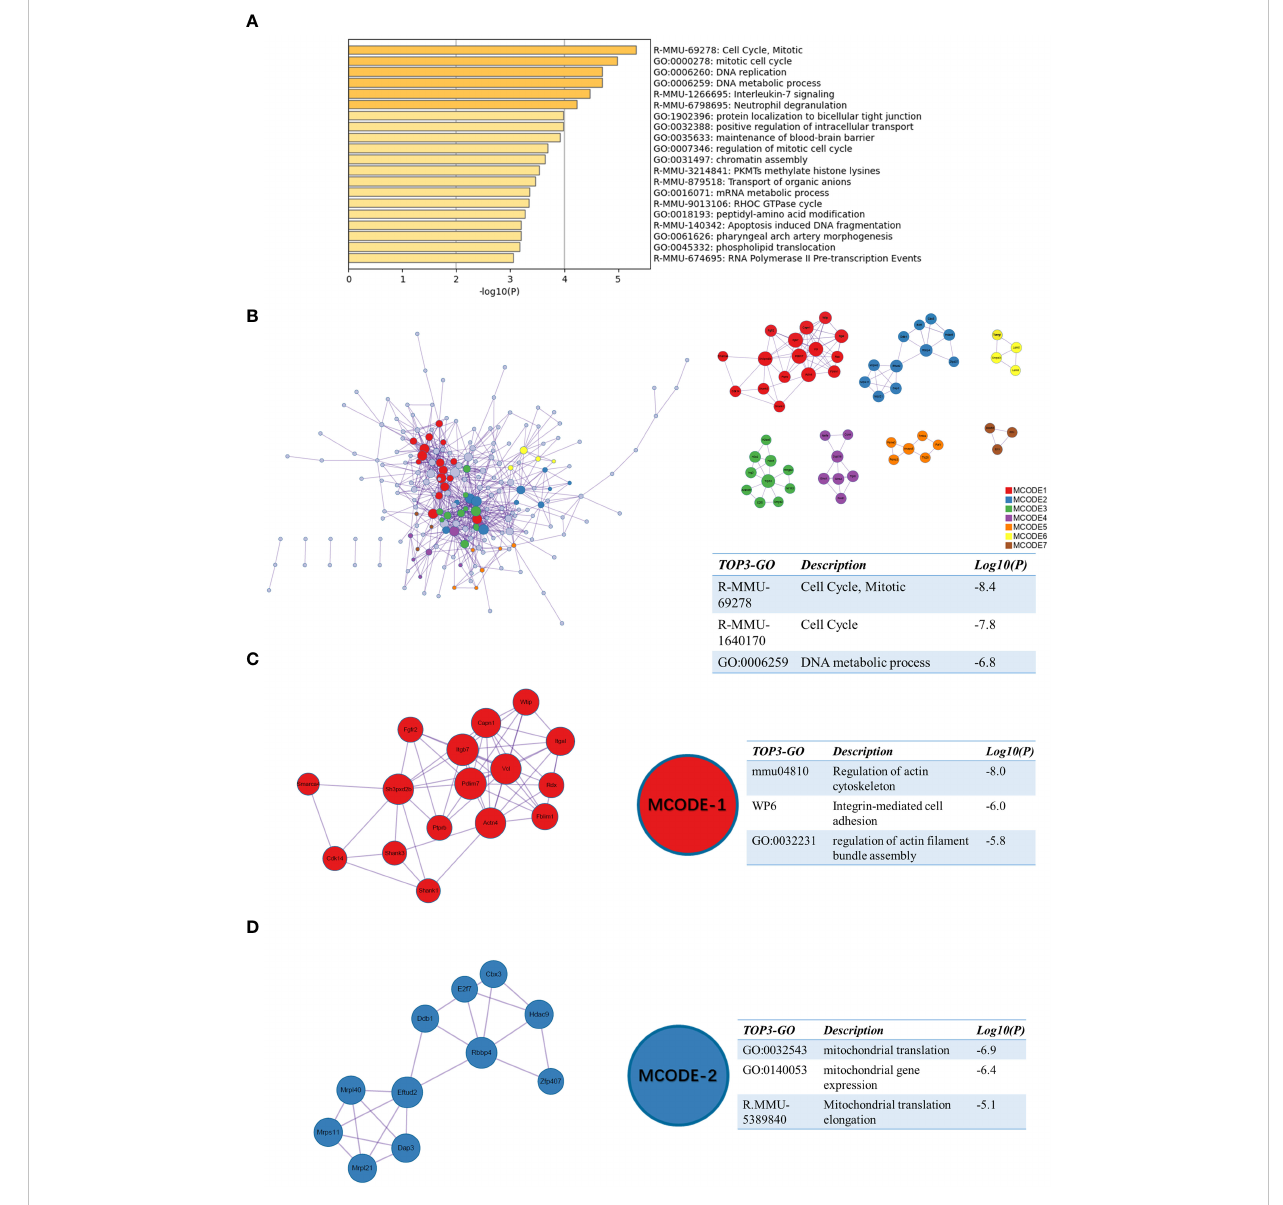
FIGURE 5 Functional enrichment of the sc_S4 on day 1 after tMCAO. (A) The top 20 enriched terms of the sc_S4 on day 1 by Metascape, colored by p-values. (B) Protein-protein interaction network and all MCODE components identi fi ed of the sc_S4 on day 1. (C, D) Representative MCODEs with correlation to enrichment analysis of the